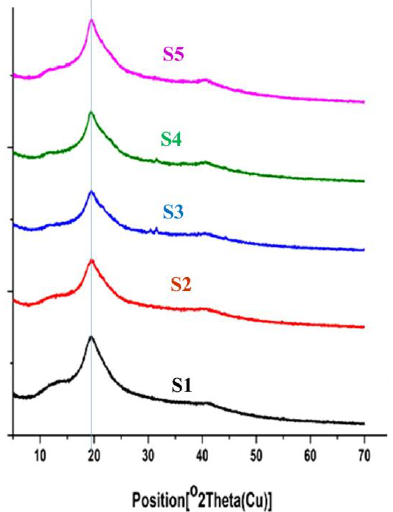
Figure 3 . X - ray diffraction patterns of the MOE/SA/PVA. Figure 3. X-ray diffraction patterns of the